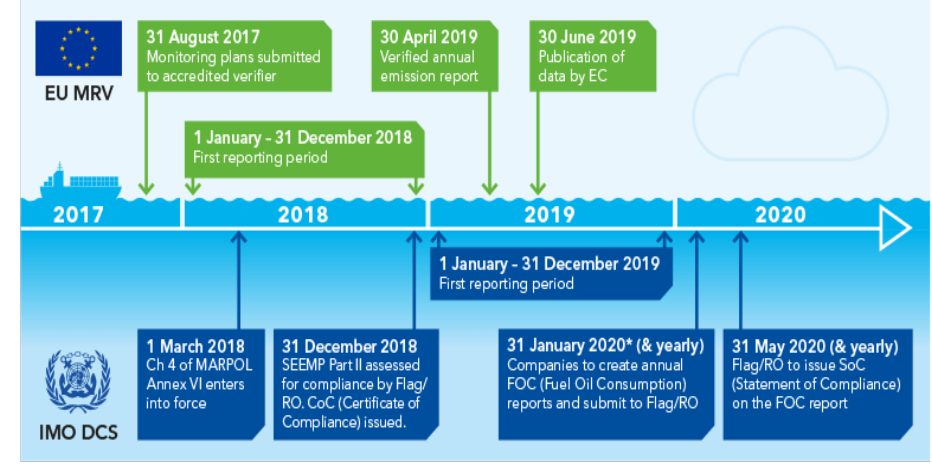
Fig. 2. Plan to put the MRV system into